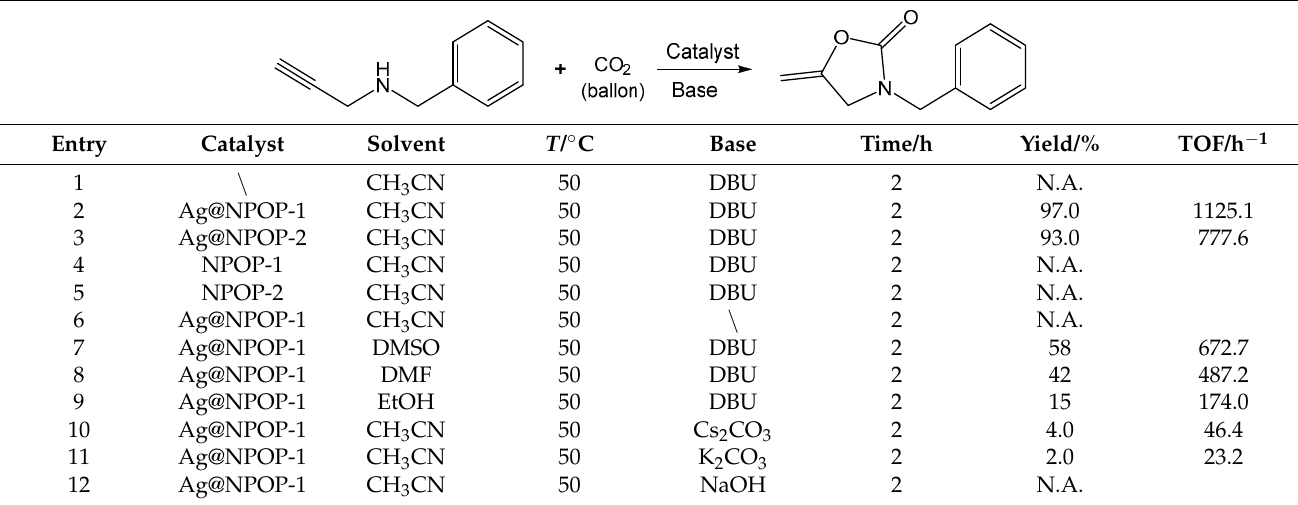
Table 1. Catalysis of NPOPs and Ag@NPOPs for the carboxylative cyclization of propargylic amines with CO 2 a .